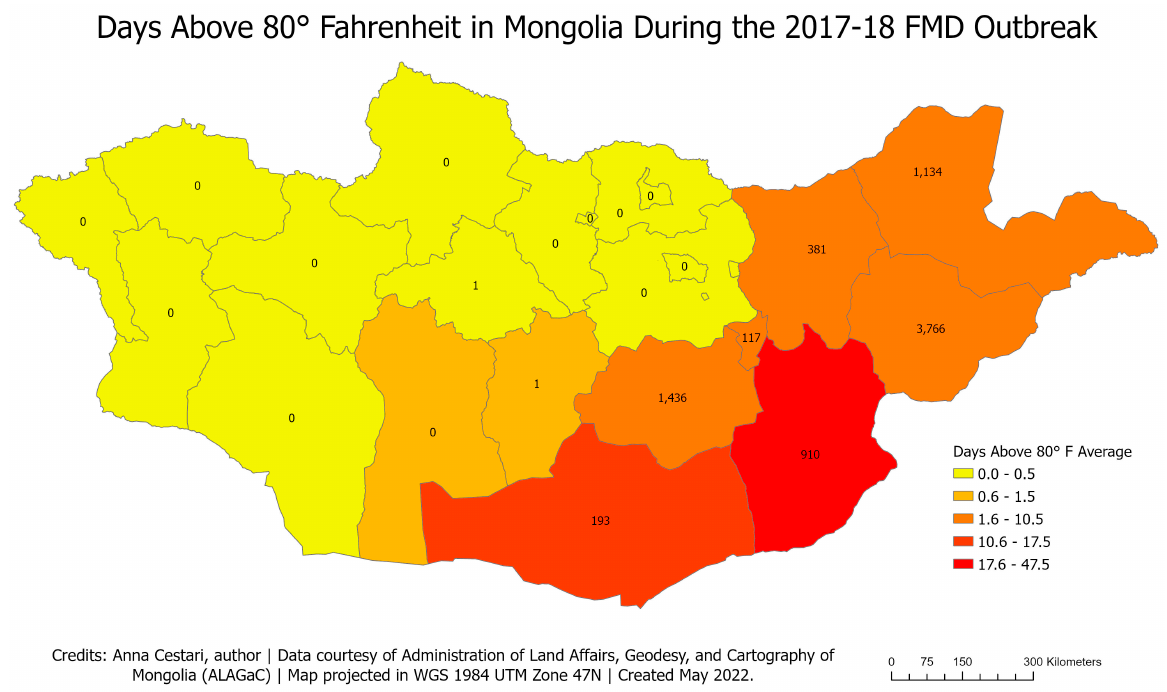
Figure 4. This map shows the provinces in Mongolia with color shading based on the number of days with temperature above 80 ◦ F. The darker colors represent more days above 80 ◦ F. Each province is labeled with its number of foot and mouth disease cases for the 2010 outbreak.